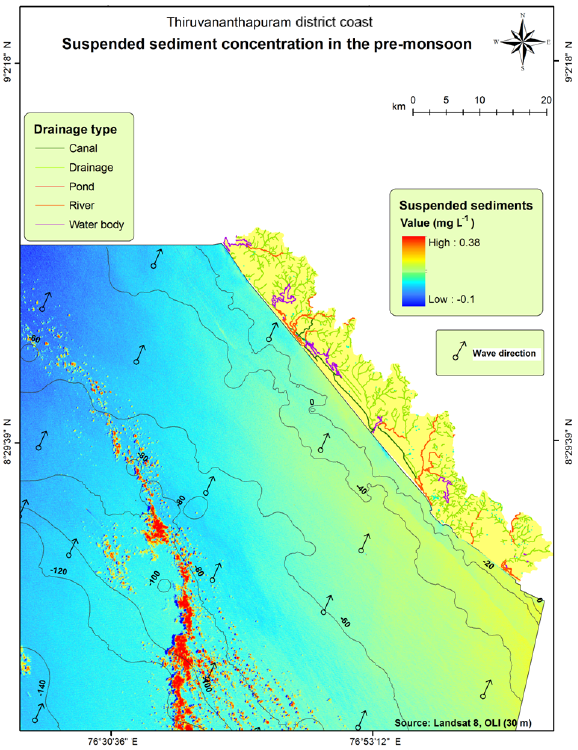
Figure 5. Suspended sediments in the post-monsoon